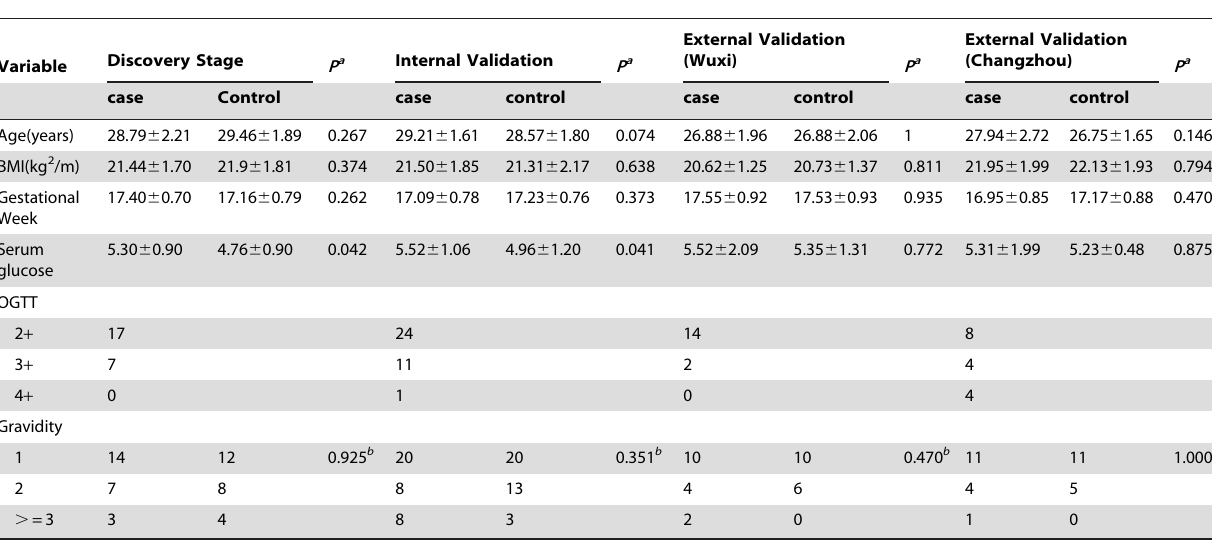
Table 1. Characteristics of the study